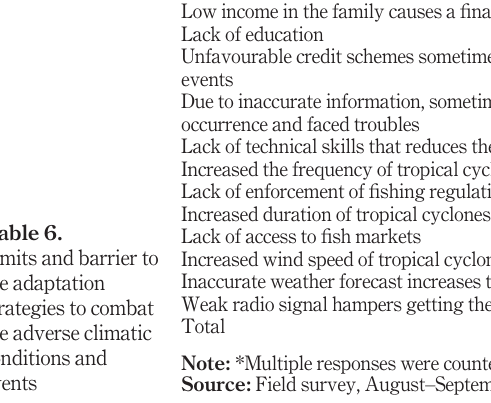
Table 6. Limits and barrier to the adaptation strategies to combat the adverse climatic conditions and events